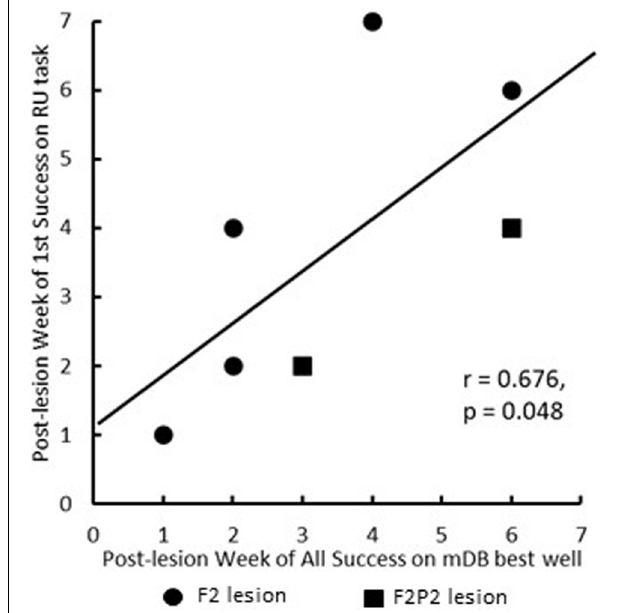
FIGURE 5 | Scattergraph showing the relationship between post-lesion week of 1 st success on the RU task and post-lesion week of consistent success (on all five trials) of the mDB best well task. Each plotted point is for a single monkey. Note that the graph does not include one F2P2 case (SDM91) that never attempted to use the contralesional hand in the RU task and another F2P2 case (SDM87) was successful in its first RU test that occurred at 5 weeks post-lesion.